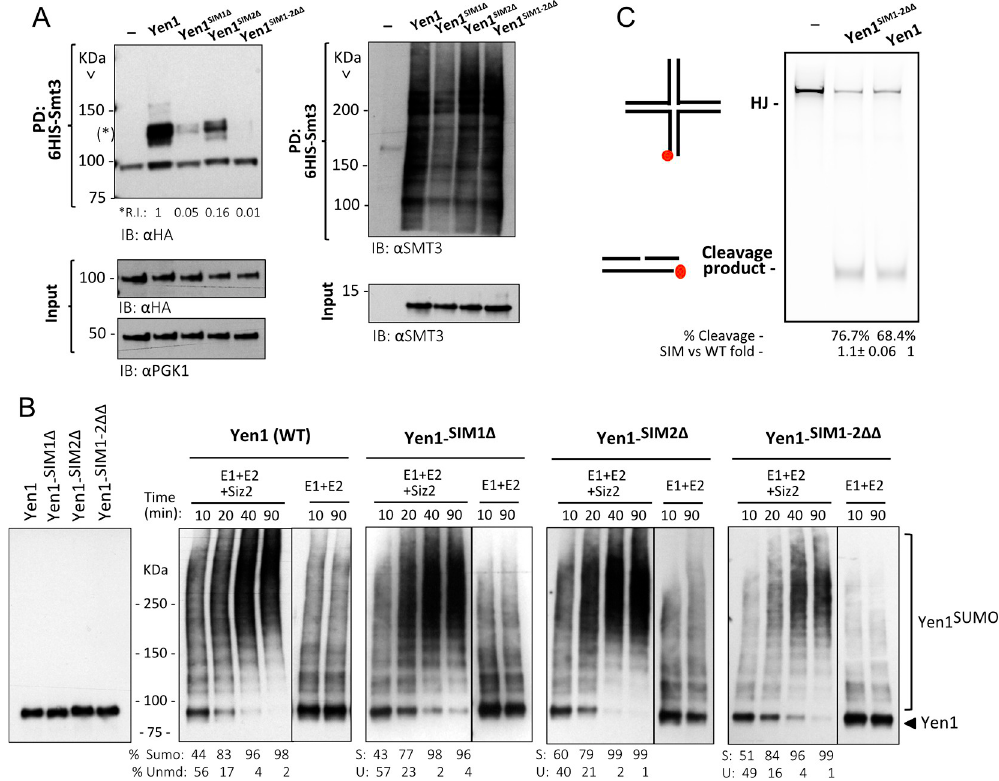
Fig 3. Mutation in Yen1 SIMs does not alter its activity or its SUMOylation in vitro but prevents SUMOylation in vivo . (A) Strains carrying endogenous copies of–HA tagged wild type Yen1, Yen1 SIM1 Δ , Yen1 SIM2 Δ and Yen1 SIM1-2 ΔΔ mutants, with or without (-) the plasmid pCUP-6xHIS-Smt3, were grown in the presence of MMS 0.3%. Cells were lysed and lysates subjected to a denaturing Ni-NTA pull-down followed by immunoblot analysis. Yen1 was detected by anti-HA. Membranes were subsequently probed with anti-Smt3. Prior to Ni-NTA pull-down, input samples were taken from the lysates and were analyzed by immunoblotting for the levels of Smt3 induction (Anti-Smt3) and relative protein amounts (Anti-PGK1, Anti- HA) of each lysate (input panels). (B) Purified Yen1-HA and Yen1 SIM-mutant variants were subjected to an in vitro SUMOylation reaction containing Siz2, Aos1-Uba2, Ubc9 and Smt3-3KR and ATP and subjected to Tris-Acetate PAGE for comparison of their SUMOylation patterns after immunoblotting with anti-HA. The reaction without the ligase Siz2 is shown at the right of each panel. Quantification of the relative % of SUMOylation forms (R.I.) and unmodified forms is shown at the bottom and more in detail in S4 Fig (C) Activity of Immuno-precipitated Yen1 was tested in a cleavage reaction using synthetic Holliday junctions (HJ) made with oligonucleotides and labeled with Cy5. The DNA products were run in non-denaturing PAGE and revealed by the fluorescence of the Cy5 labeled oligonucleotide.